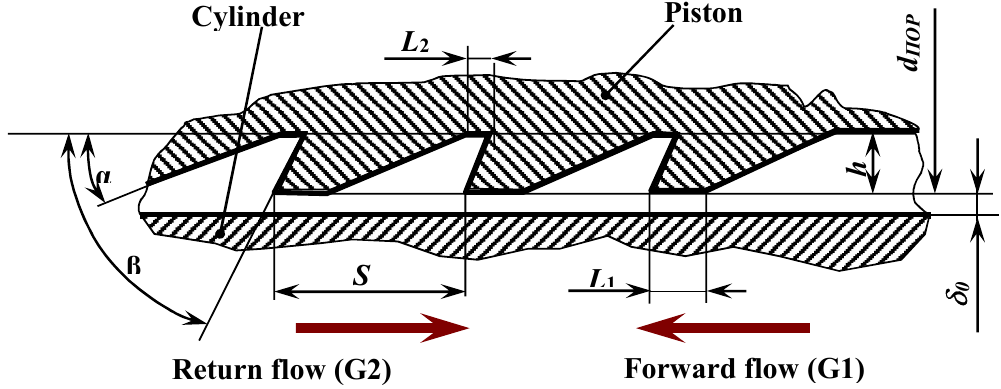
Figure 2. Scheme of the transverse gap seal of the PHPM piston made in the form of a hydrodiode.